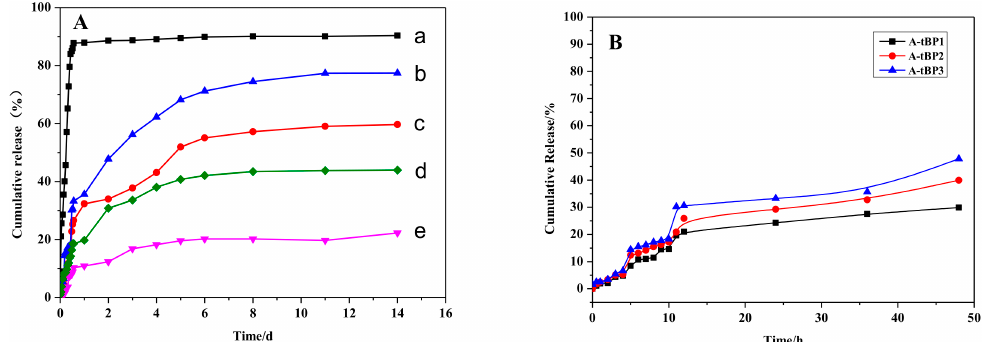
Figure 9. The drug release profiles ( A ) of anethole-loaded micelles: (a) pure anethole; (b) A 1 -tBP3 (DL = 5.1%) at 37 °C; (c) A 1 -tBP3 (DL = 5.1%) at 25 °C; (d) A 2 -tBP3 (DL = 7.9%) at 37 °C; (e) A 2 -tBP3 (DL = 7.9%) at 25 °C; and ( B ) of anethole-loaded micelles of A-tBP1 (DL = 5.7%), A-tBP2 (DL = 5.3%), and A-tBP3 (DL = 5.1%) at 37 °C.